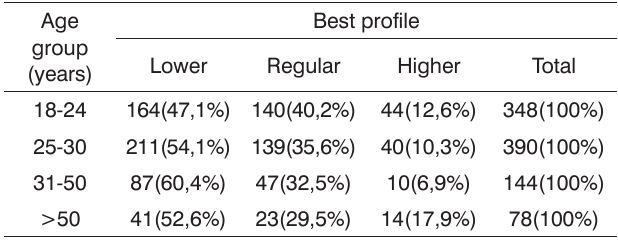
Table 3. Best profile per age group of interviewees